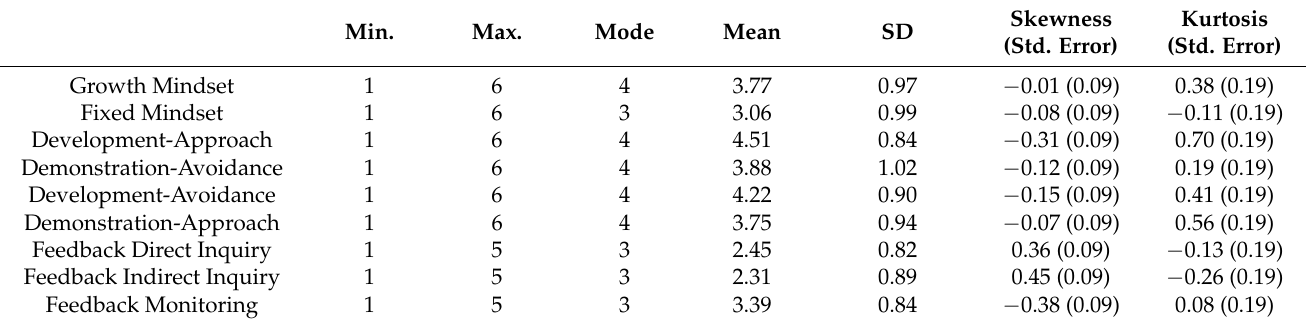
Table 1. Descriptive Statistics of Learners’ Mindsets, Achievement Goals, and FSBs. Min.